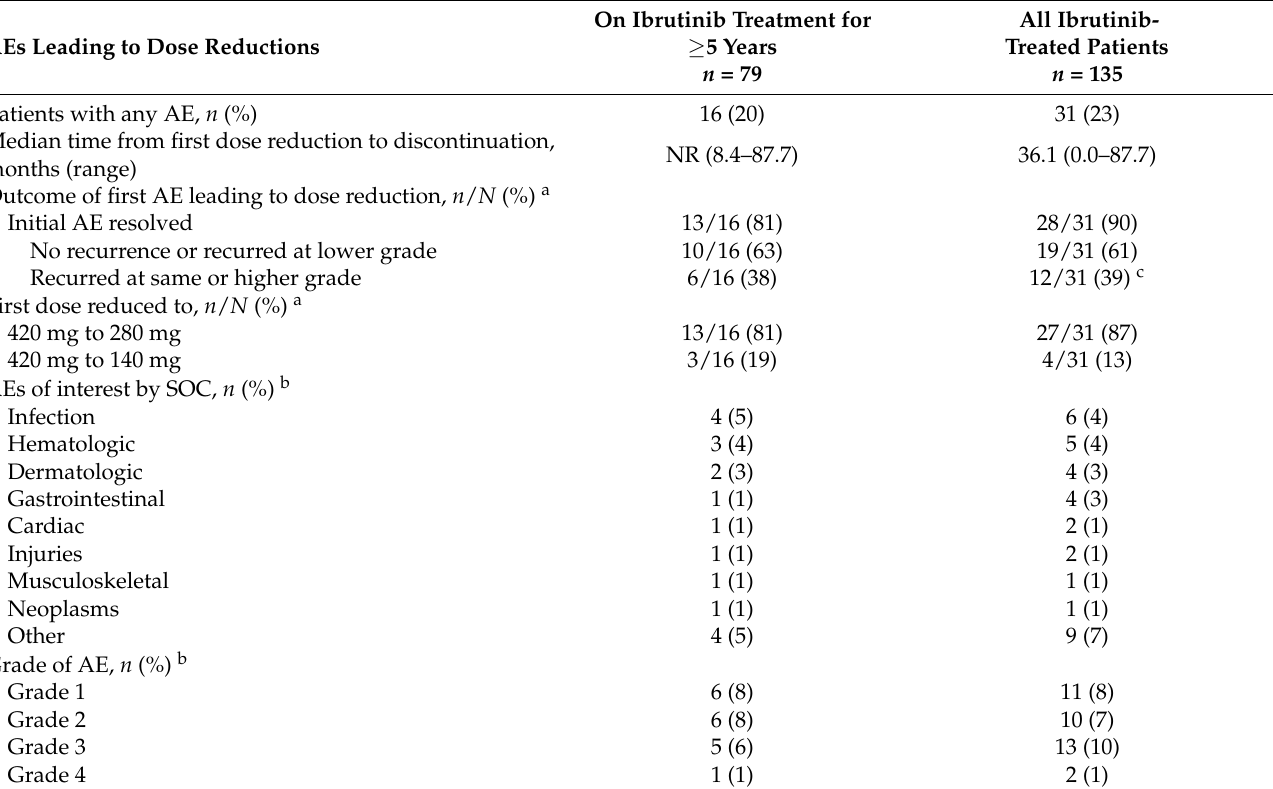
Table 2. AEs leading to dose reductions per